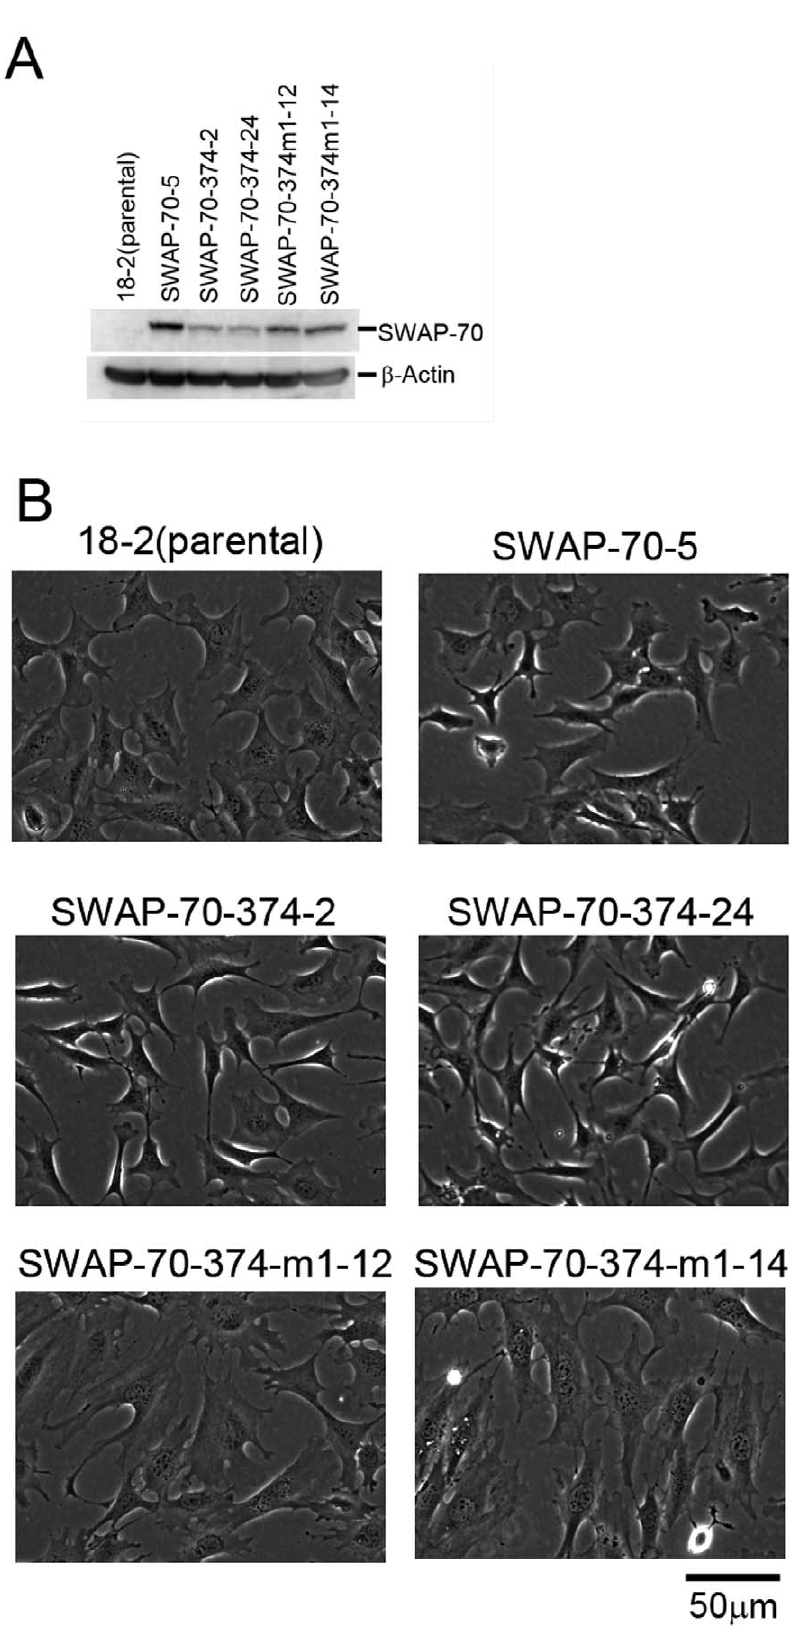
Figure 4. Morphologic transformation of MEFs expressing exogenous SWAP-70. A, Western blotting analysis of the exogenously expressed SWAP-70. Western blotting of SWAP-70 was done using cell lysate from each line (30 m g protein) (upper panel). b -actin was also detected as a control (lower panel). B, Cell morphology of MEFs expressing exogenous SWAP-70s. Cells were plated at a density of 3 6 10 5 cells in 6-cm dishes. After cultivation for 1 day, cell morphology was observed under the microscope. doi:10.1371/journal.pone.0014180.g004 PLoS ONE |